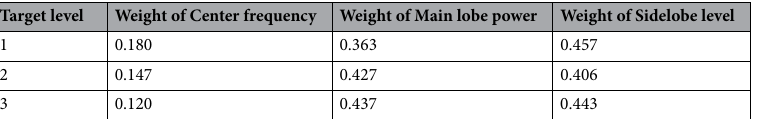
Table 2. Final weighting factor calculated by Delphi method for different target level. The results show that the selection of the best weight factor depends on the target conditions, and the center frequency is easier to optimize while SLL is more difficult and needs a higher